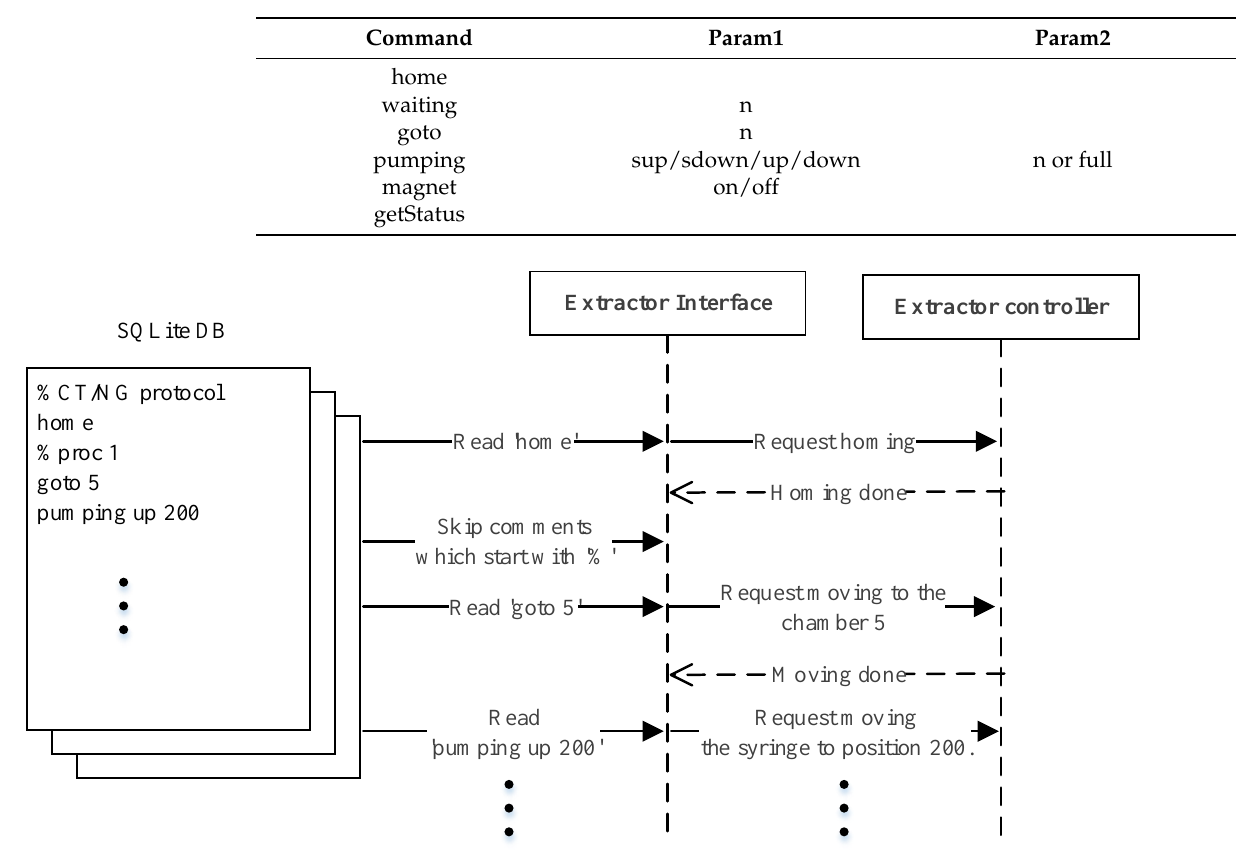
Table 1. High-level command set for DNA extraction.